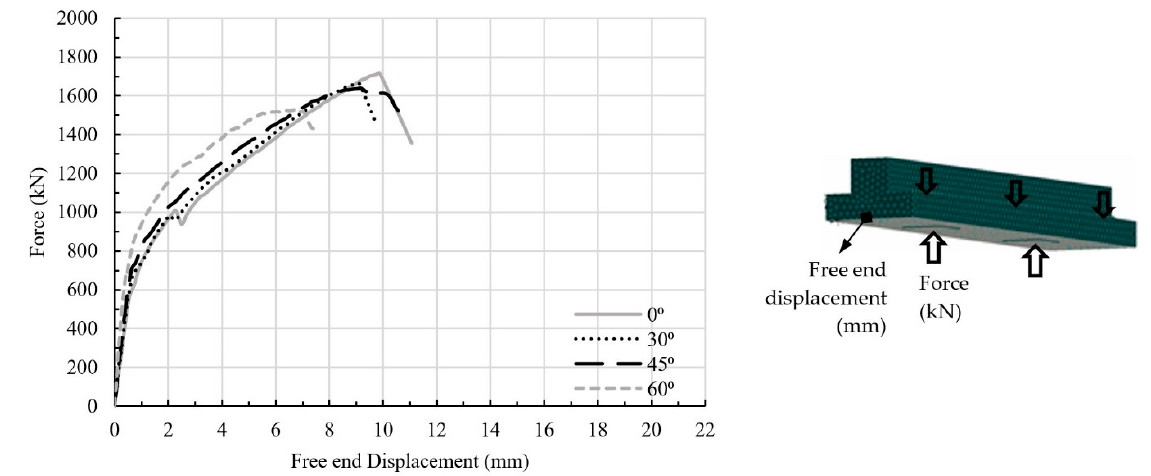
Figure 9. Comparison of force-displacement response of inverted T-beams with different skew angles.